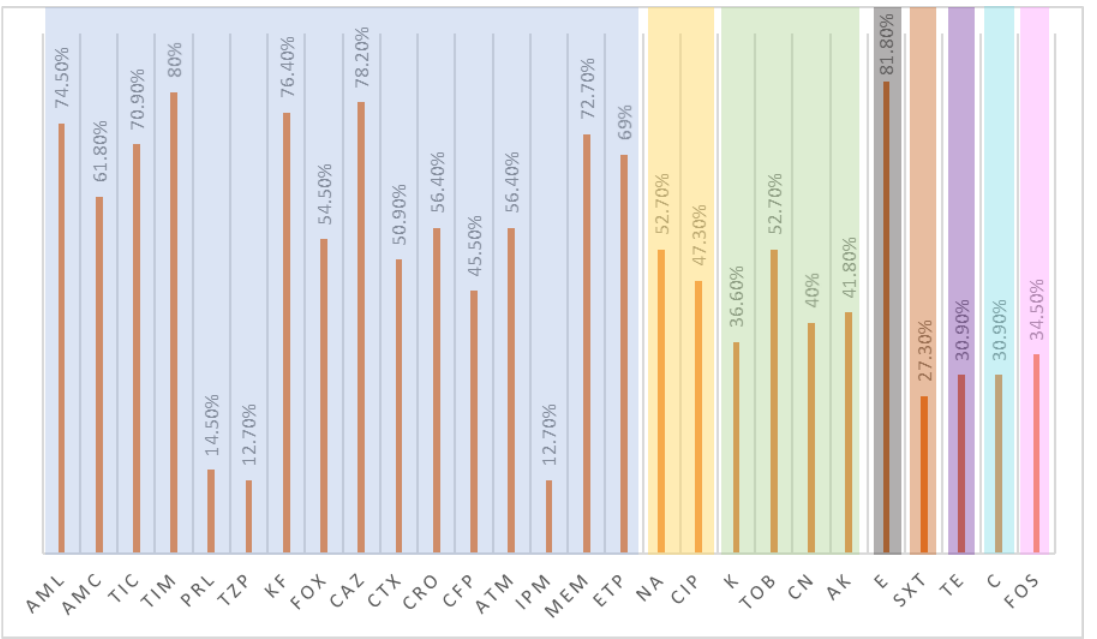
Figure 2. Percentage resistance towards each antimicrobial. β -lactam antibiotics tested included penicillins (aminopenicillins, carboxypenicillins, and ureidopenicillins), cephalosporins (1st and 3rd generations), monobactams, and carbapenems, namely amoxicillin (AML 10 ), amoxicillin/clavulanic acid (AMC 30 ); ticarcillin (TIC 75 ), ticarcillin/clavulanic acid (TIM 85 ); piperacillin (PRL 100 ), piperacillin/tazobactam (TZP 110 ); cephalothin (KF 30 ); cefoxitin (FOX 30 ); ceftazidime (CAZ 30 ); cefotaxime (CTX 30 ); ceftriaxone (CRO 30 ); cefoperazone (CFP 30 ); aztreonam (ATM 30 ); imipenem (IMP 10 ), meropenem (MEM 10 ), and ertapenem (ETP 10 ) — dark blue box. Quinolones (nalidixic acid — (NA 30 )/quinolone, ciprofloxacin — (CIP 5 )/fluroquinolone) — yellow box. Aminoglycosides (kanamycin (K 30 ); tobramycin (TOB 10 ); gentamicin (CN 10 ); amikacin (AK 30 )) — green box. Macrolides (erythromycin (E 15 ) —grey box. Combination of sulfamethoxazole/trimethoprim (SXT 25 )—orange box. Tetracycline (TE 30 )—purple box. Amphenicols (chloramphenicol (C 30 )—light blue box. Fosfomycin (FOS 50 )—pink